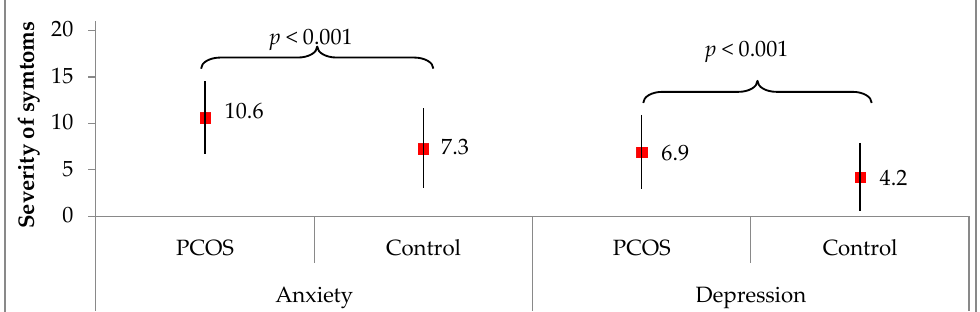
Figure 3. Severity of anxiety and depression symptoms acc. to HADS in the PCOS group and control group. Results are presented as mean ± standard deviation. p for Student’s t test. Scale 0 – 21: 0 – 7 none, 8 – 10 mild, 11 – 14 moderate, 15 – 21 severe.